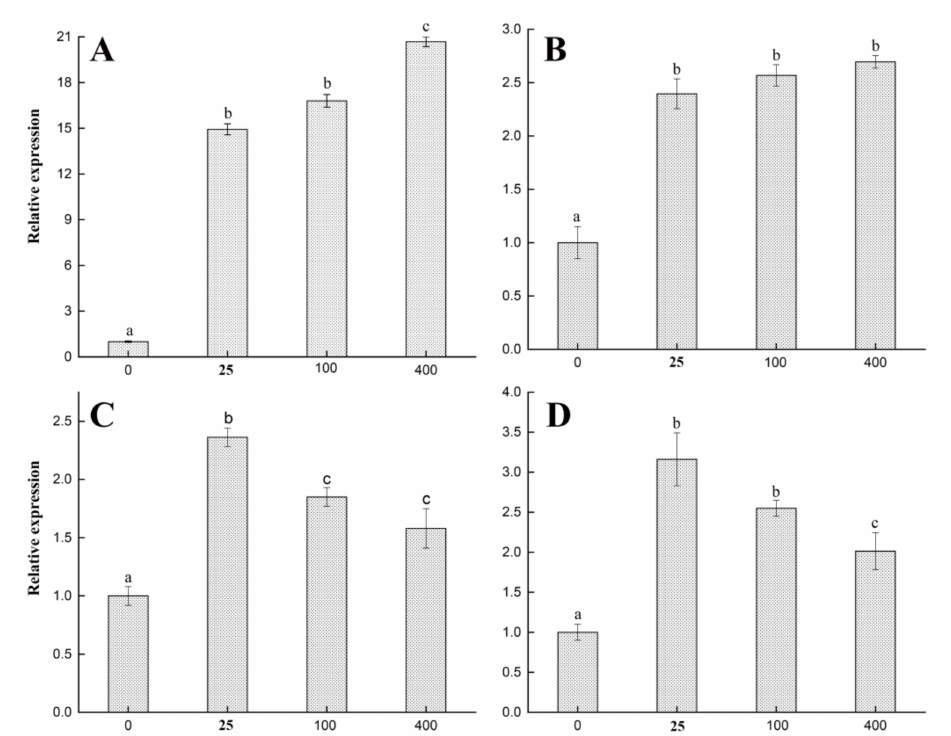
Figure 7. Effects of SPP-0.7A on expression level of serum cytokines, IL-6 ( A ), IL-1 β ( B ), TNF- α ( C ), and iNOS ( D ) in RAW 264.7 cells. All data are expressed as mean ± SD. Significant difference ( p < 0.05) between groups according to one-way ANOVA test are labeled with different